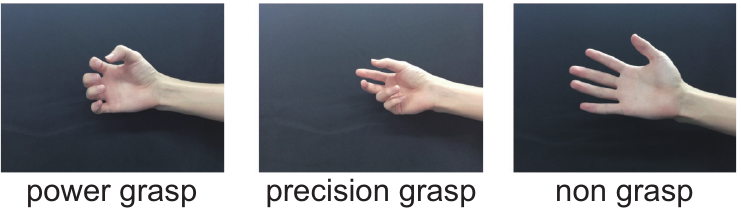
Figure 6. Differences among power grasp ( left ), precision grasp ( middle ), and non-grasp ( right